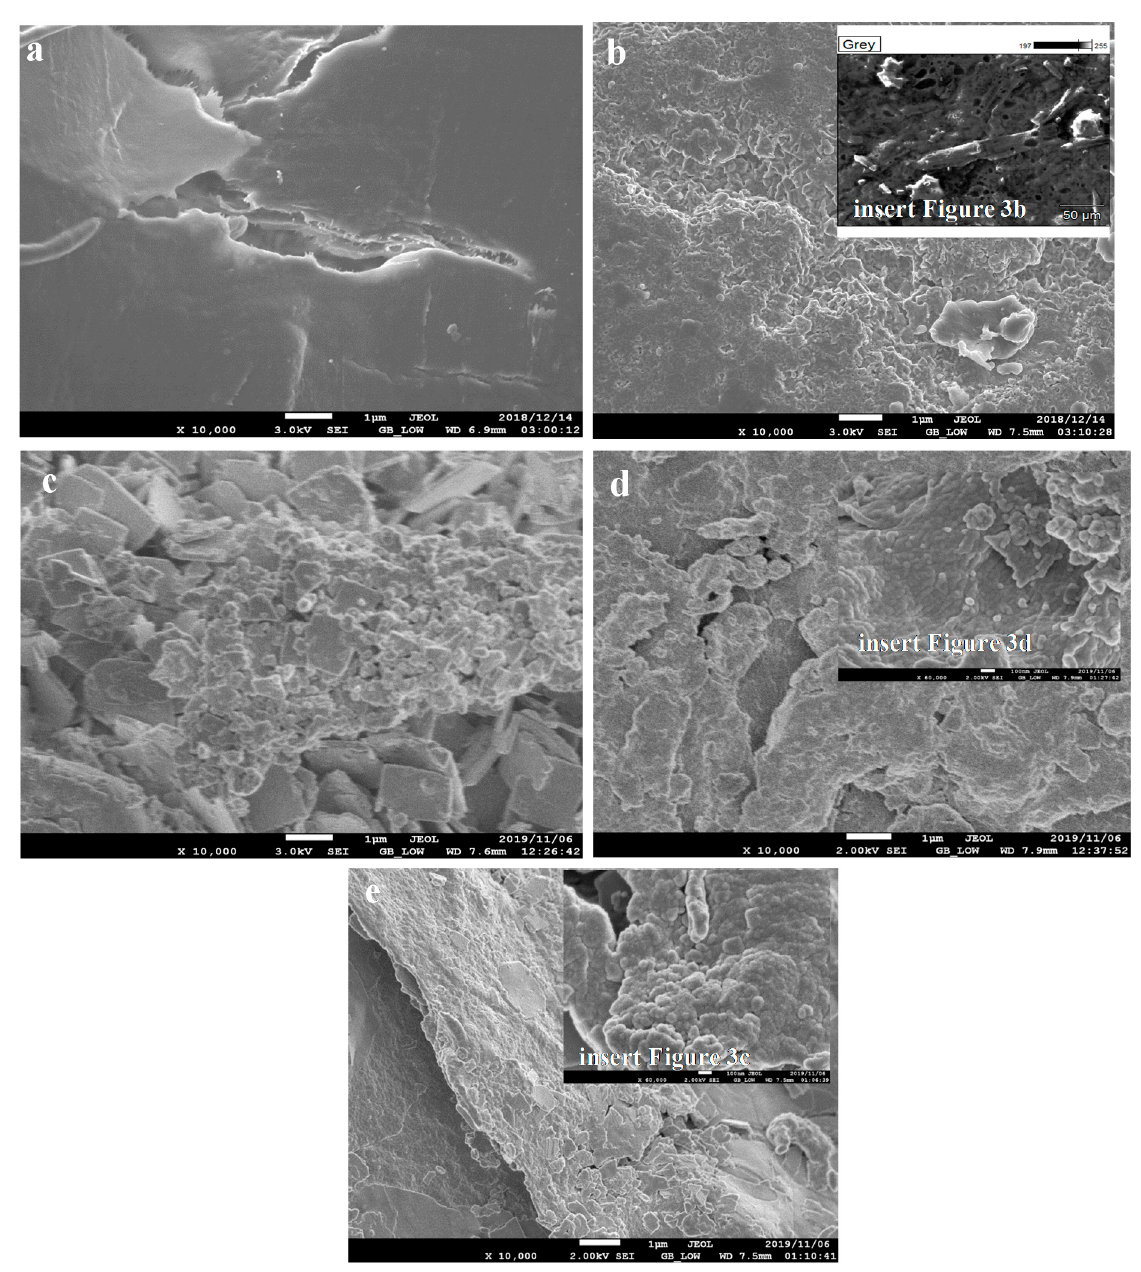
Figure 3. SEM images of: ( a ) Raw CNC (unmodified) ( b ) NaNO 2 /NaHCO 3 modified CNC, insert Figure 3b: MCNC ×50 µ ( c ) Pb-flocs ( d ) Cu-flocs, insert Figure 3d: Cu-flocs magnification ×60,000 ( e ) Fe-flocs, insert Figure 3e: Fe-flocs magnification ×60,000. Table 1. EDS analysis of MCNC, and floccules formed during the coagulation process.